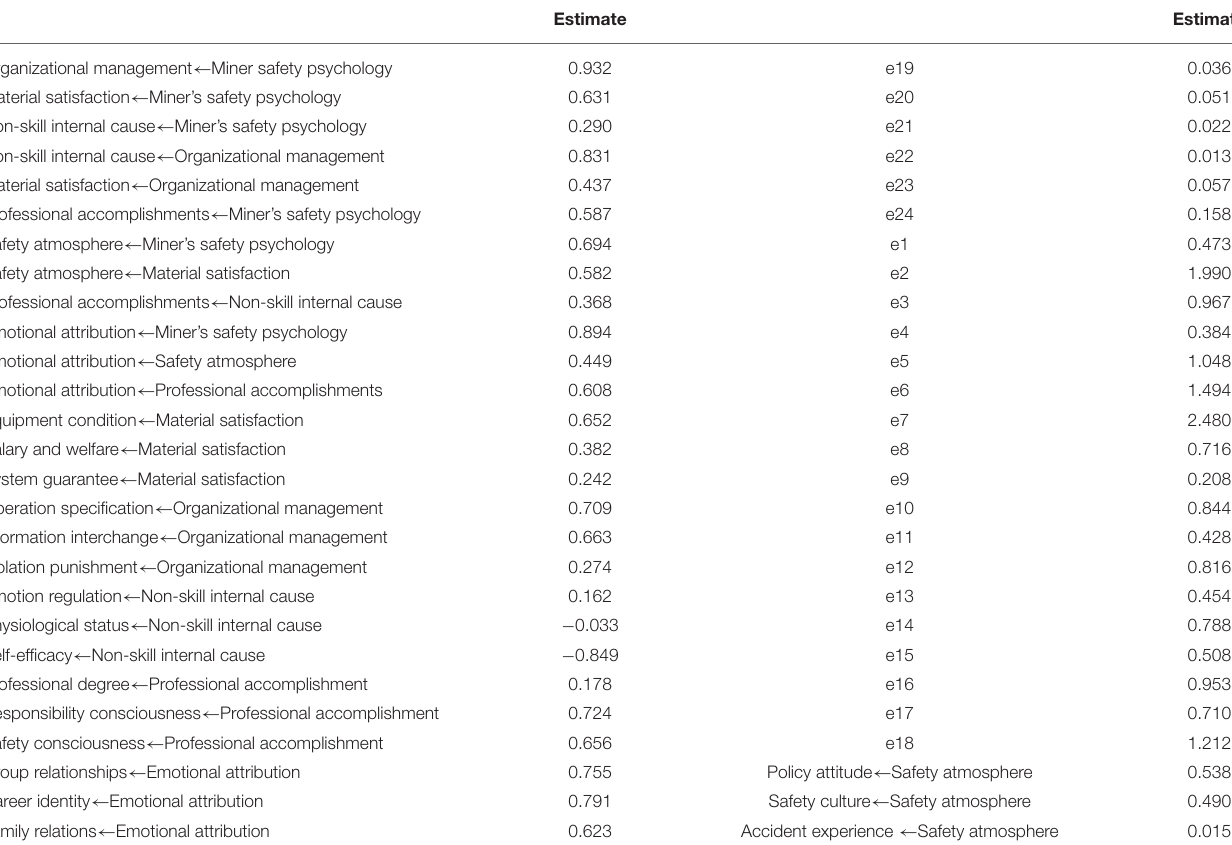
TABLE 9 | Variance and normalization coefficient table of model. Estimate